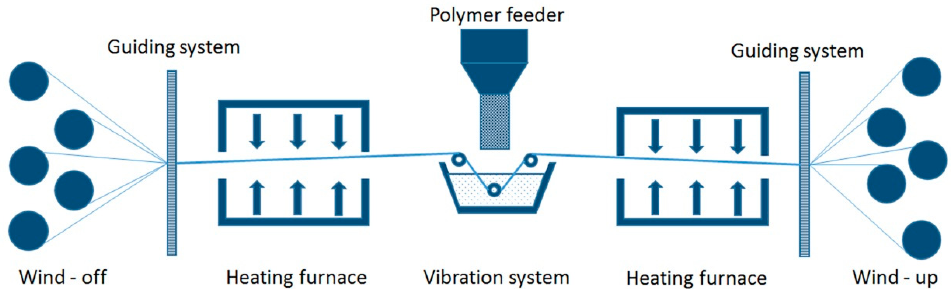
Figure 9. Schematic illustration of a towpreg production machine.